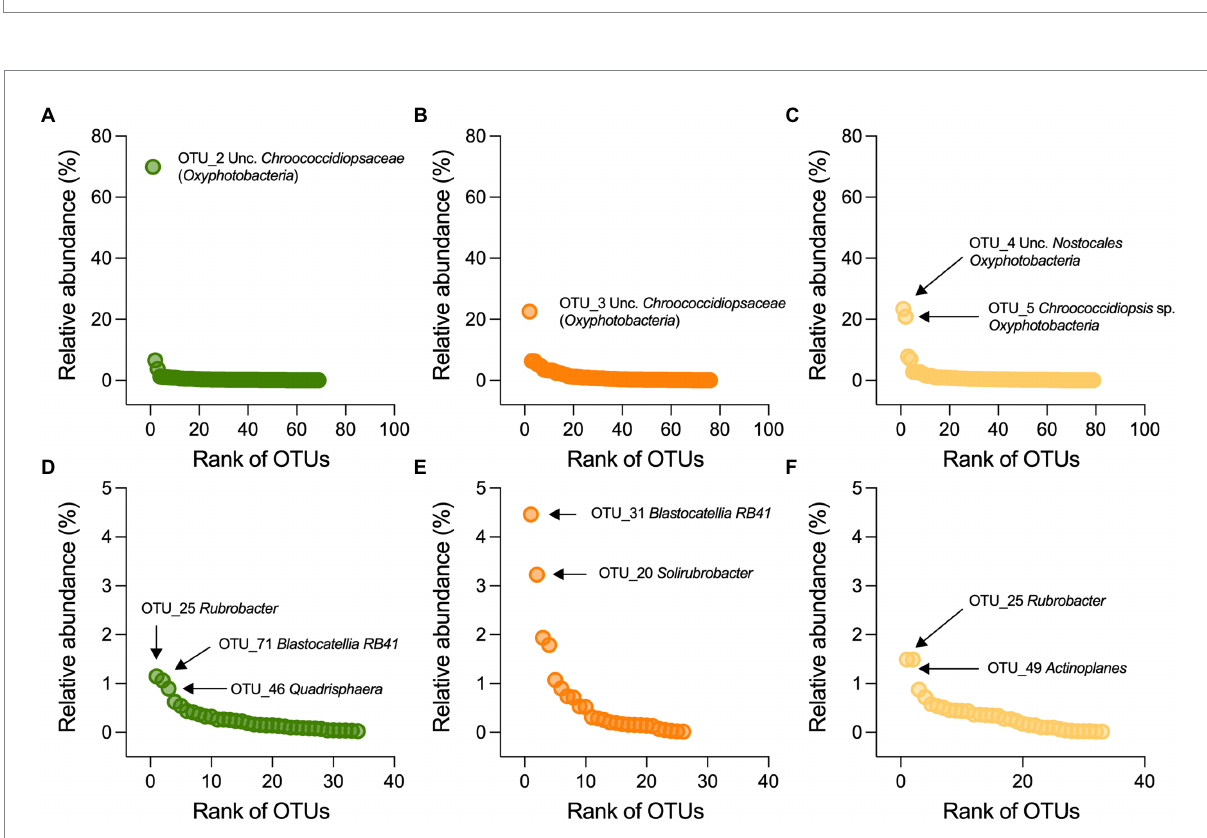
FIGURE 4 Distribution and taxonomic classification of dominant OTUs. Rank-abundance plots for (A–C) bacterial and ( D – F ) actinobacterial OTUs associated with stone from the Mediterranean (green), semiarid (orange) and arid (yellow) ruins; the OTUs are ranked on the x-axis based on their relative abundance (y-axis), from the most abundant (left side) to the lowest abundant (right side). Taxonomic affiliation of the dominant OTUs is also